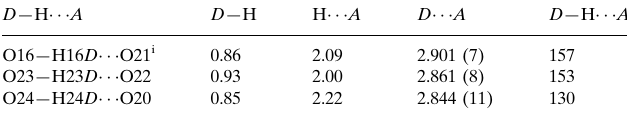
Hydrogen-bond geometry (A˚ , (cid:3)